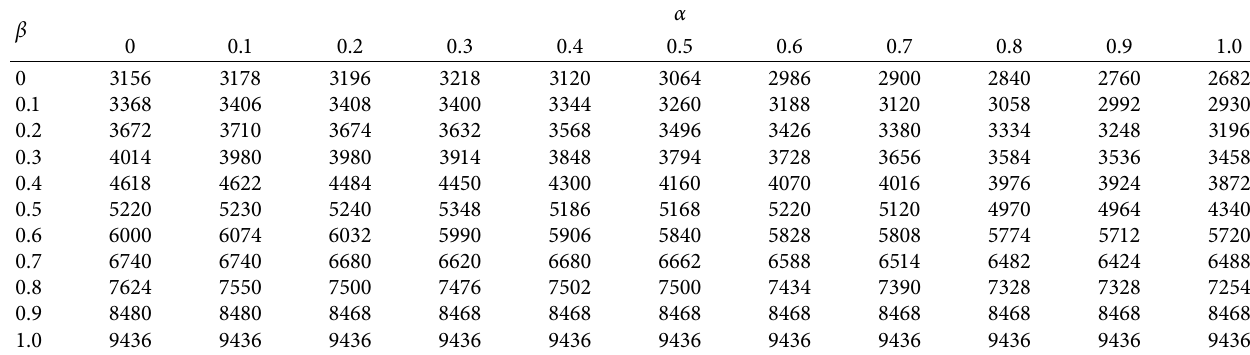
Table 6: Distribution of demand growth multiplier under different market